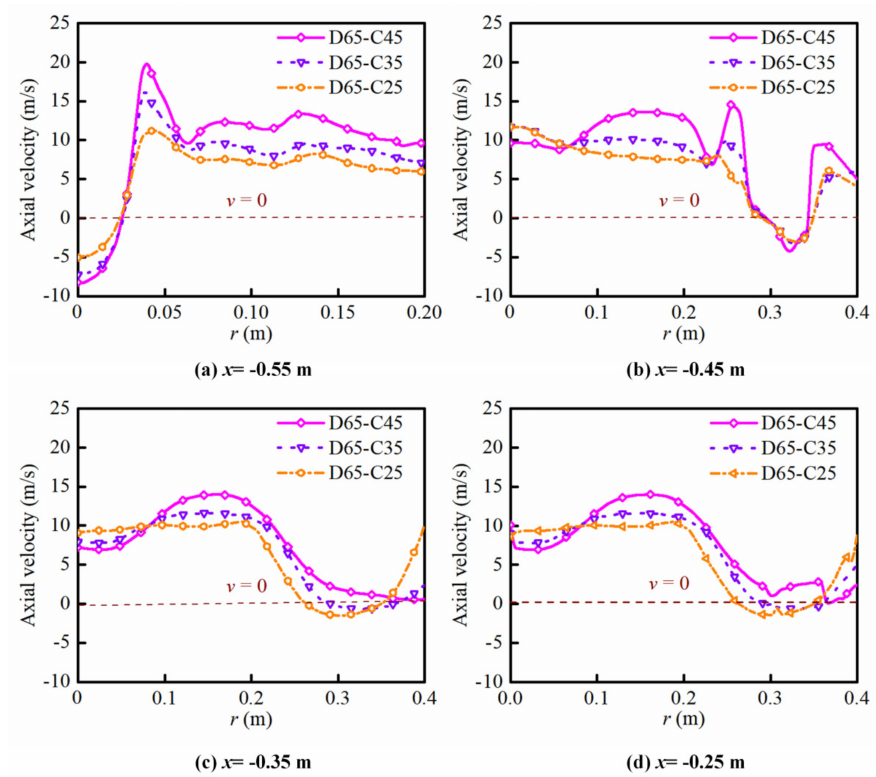
Figure 18. Axial velocity distribution of D65-C45, D65-C35, and D65-C25 at different axial positions.